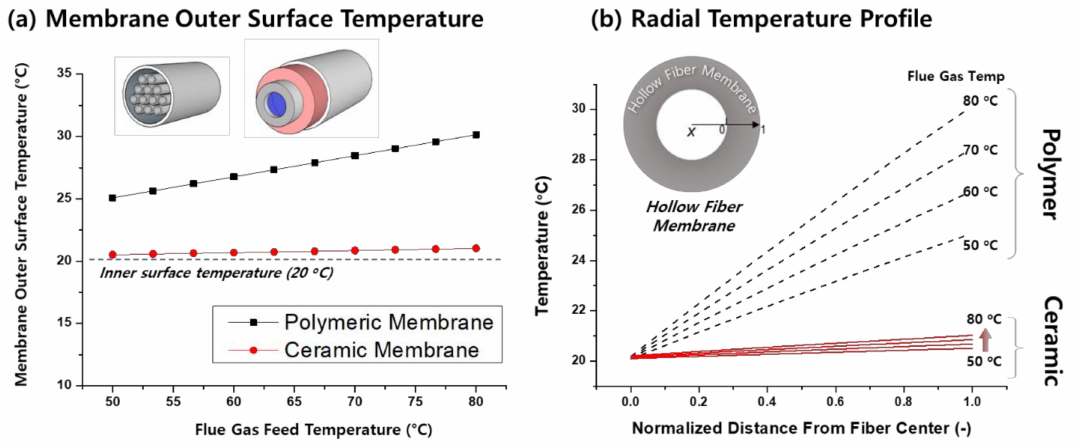
Figure 7. Comparison of ceramic and polymeric materials on ( a ) membrane outer surface temperature and ( b ) radial temperature profile as a function of flue gas temperature (reprinted with permission from [6]).